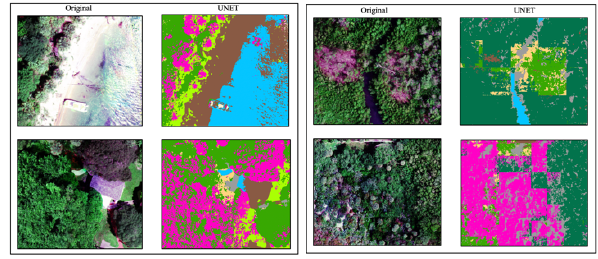
Figure 13: Misclassified